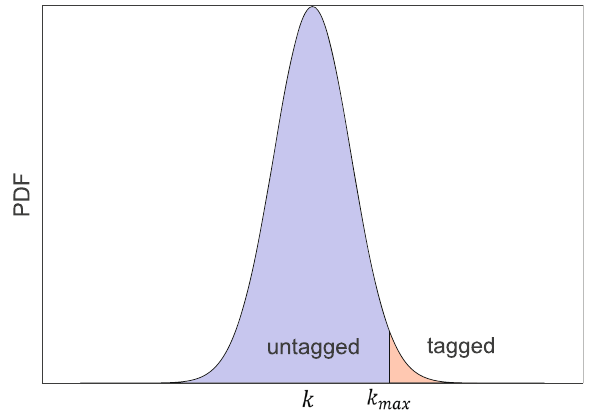
Fig. 5 A cutoff for untagged state. Here, we apply a cutoff k max to increase the probability of untagged Gaussian